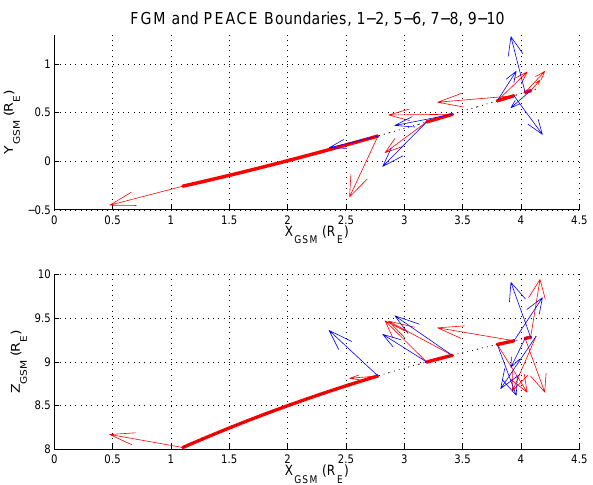
Fig. 2. Projection on Cluster orbit trajectory of boundary normal pairs from cusp crossings, 1a–2, 5–6, 7–8 and 9–10, in GSM coor- dinates. The thick red lines indicate the region of “cusp” bounded by the boundary pair. The red arrows are unit normals derived by PTA and the blue arrows normals from